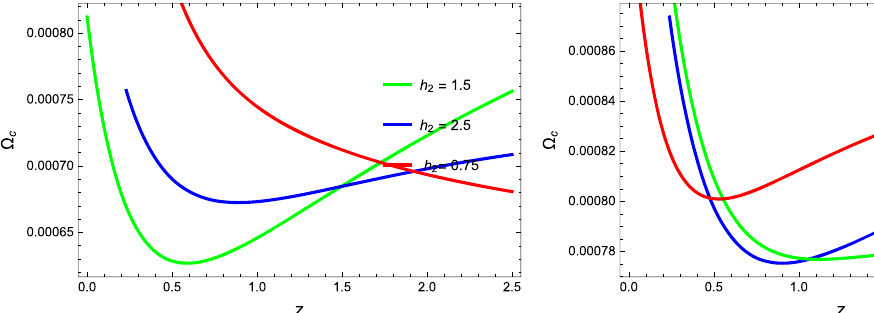
Fig. 15 Evolution of dark energy density parameter versus z